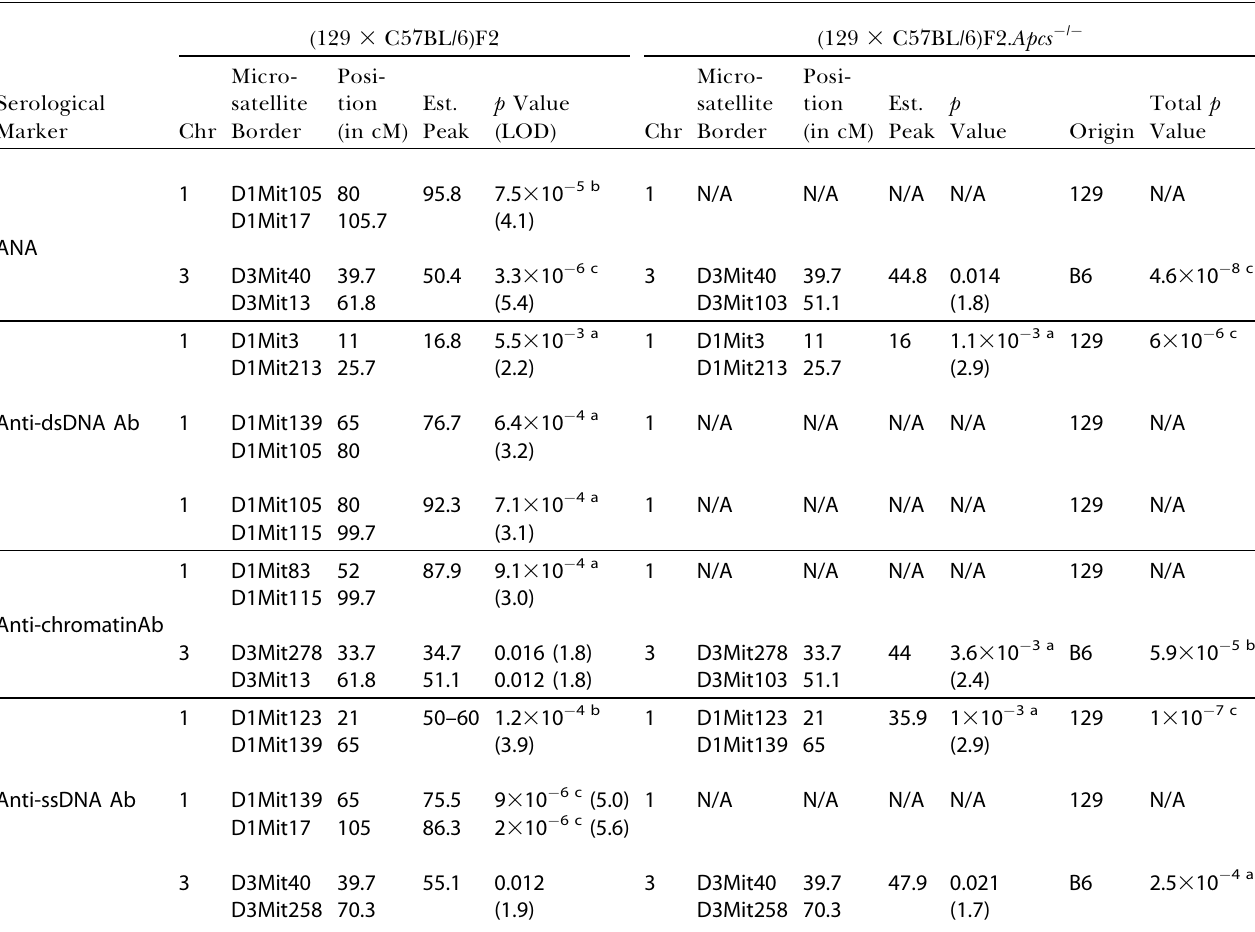
Table 3. Summary of Genome-Wide Linkage Analysis in Apcs (cid:1) / (cid:1) and Wild-Type (129 3 C57BL/6)F2 Female Mice